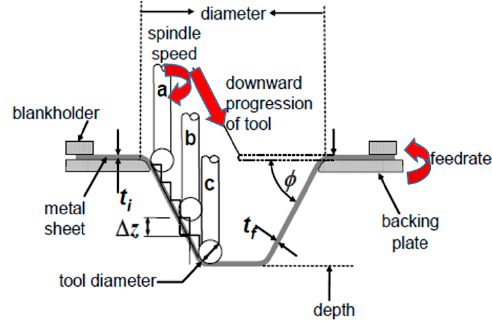
Figure 1. Single-point incremental point (modified from [6]).